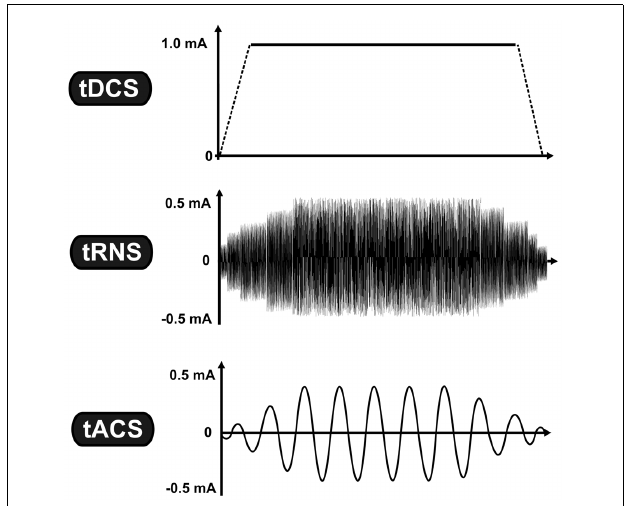
FIGURE 1 | Transcranial electrical stimulation is a specific subgroup of non-invasive brain stimulation techniques, which is based on the application of low-intensity electrical current. While tDCS uses constant current intensity, tRNS and tACS use oscillating current. The vertical axis represents the current intensity in milliamp (mA), while the horizontal axis illustrates the time-course. Abbreviations: tDCS, transcranial direct current stimulation; tRNS, transcranial random noise stimulation; tACS, transcranial alternating current stimulation.